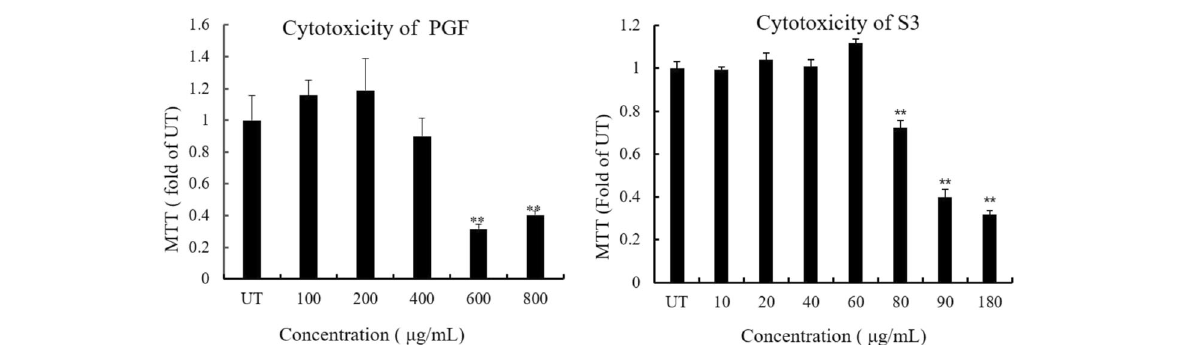
Fig. 4 Influence of the PGF and S3 on cell viability. The PGF decreased cell viability in a dose-dependent manner, as shown by the MTT assay. NCTC 1469 cells were incubated with increasing concentrations of the PGF or S3 for 18h. * * P <0.01 vs. UT (0 μ g/mL). UT indicates an untreated